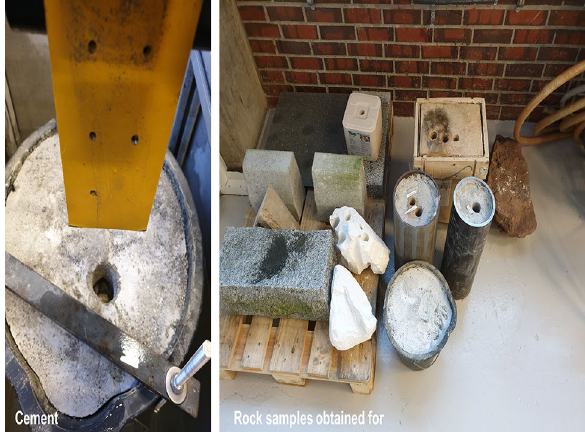
Fig. 3 Collection of different rock specimen drilled to gather experi- mental drilling